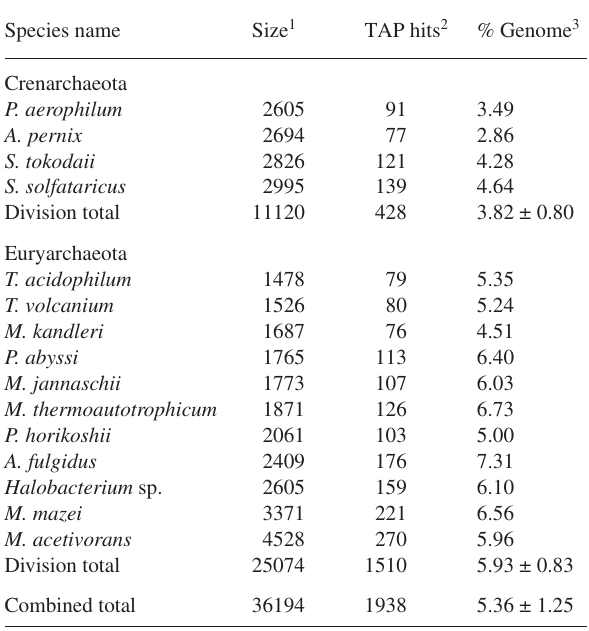
Table 1. BLASTp search results using the reference set to query fif- teen archaeal genomes